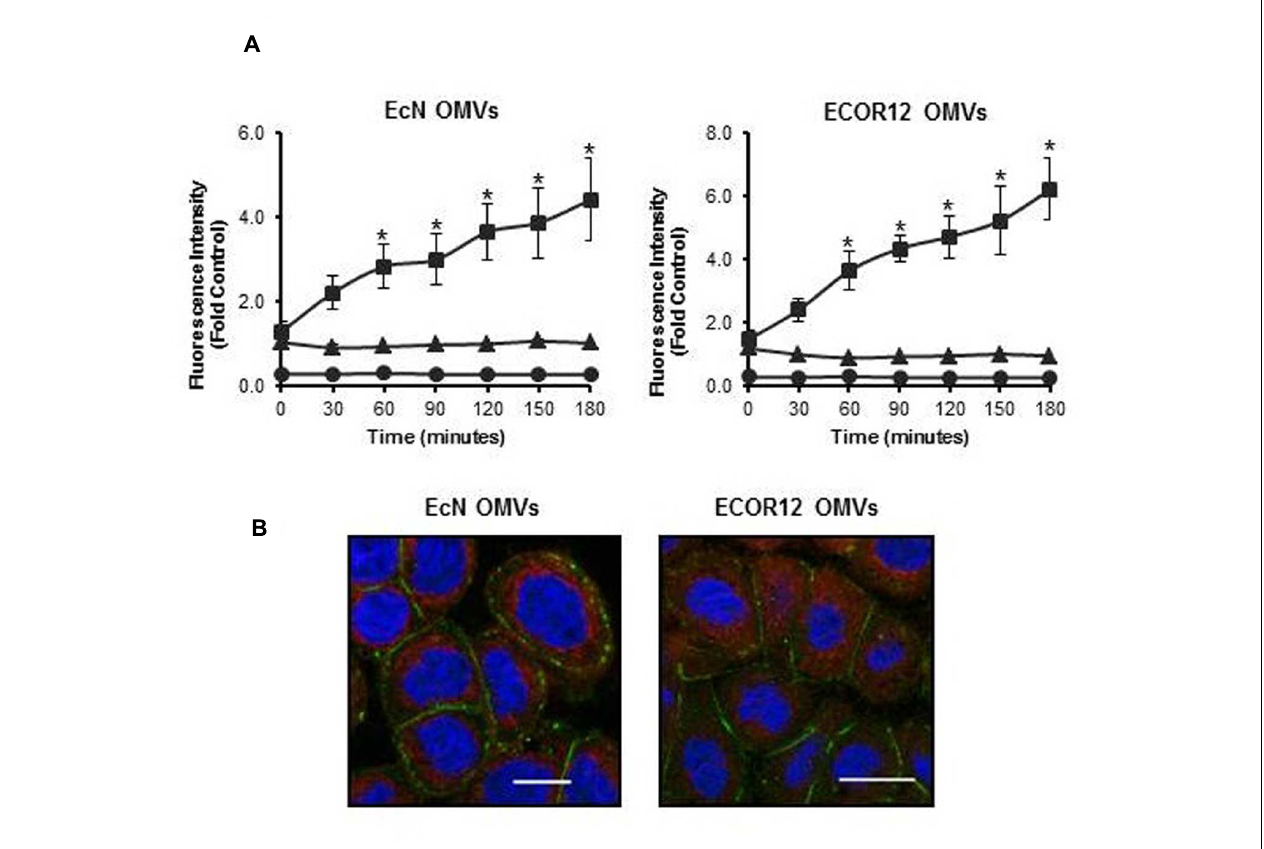
FIGURE 4 | Outer membrane vesicles uptake by differentiated Caco-2 cells. (A) Rhodamine B-R18-labeled OMVs from EcN or ECOR12 were applied to the apical side of polarized Caco-2 cells and fluorescence was measured over time (squares). OMVs (triangles) and cells (circles) alone were used as negative controls for background fluorescence. Statistical differences versus the for background fluorescence emitted by OMVs alone were assessed by one-way ANOVA followed by Tukey’s test ( ∗ p < 0.05). (B) Visualization of internalized OMVs by fluorescence microscopy. Caco-2 cells were incubated with rhodamine B-R18 labeled OMVs for 1 h at 37 ◦ C. The cell membrane was visualized by immunostaining with antibodies against the zonula occludens ZO-1 protein followed by Alexa Fluor 488-conjugated secondary antibody (green). Nuclei were stained with DAPI (blue). Internalized rhodamine-R18 labeled OMVs are visualized in red. Bar: 20 µ